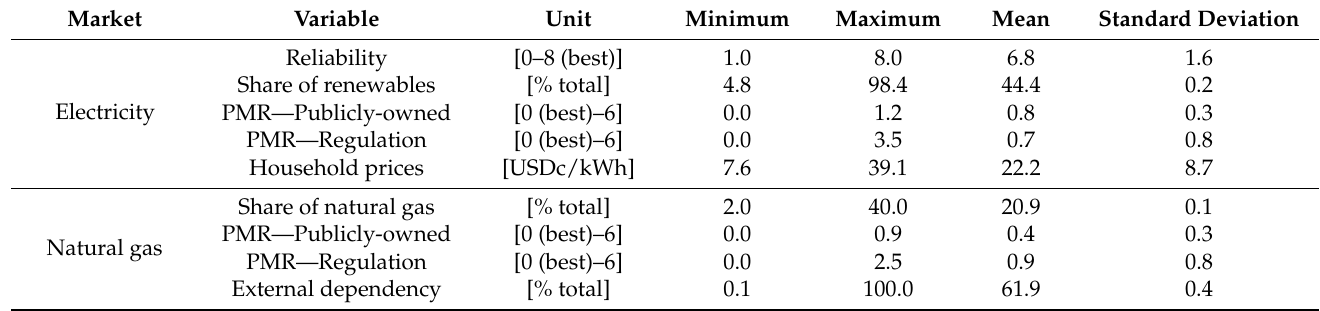
Table 5. Descriptive statistics of the variables analyzed. Source: Drawn up by the authors, based on [9,23].